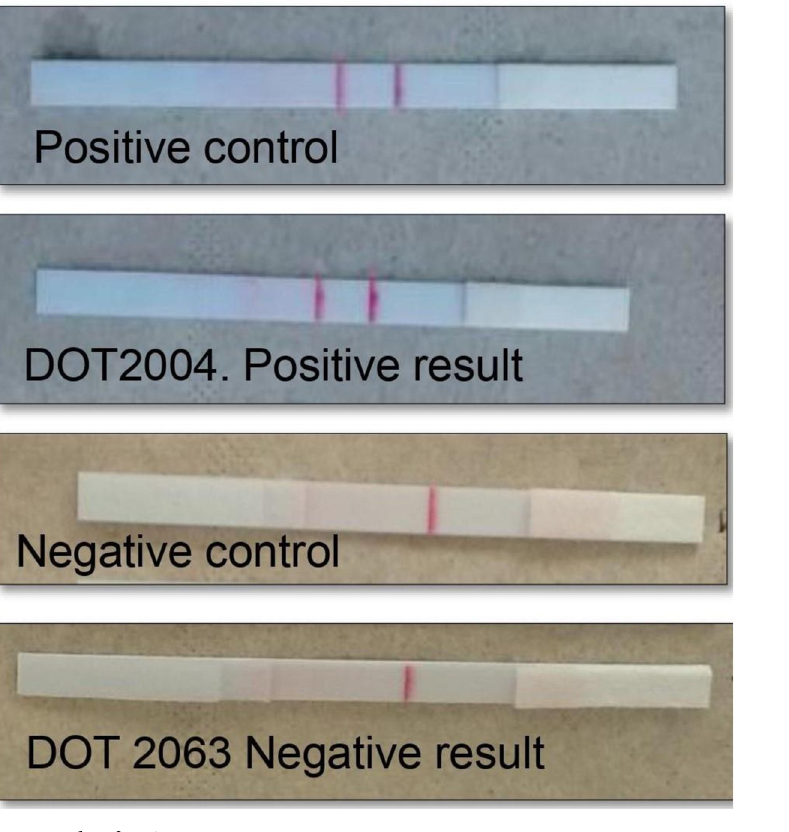
Fig 2. Results of RPA-LF